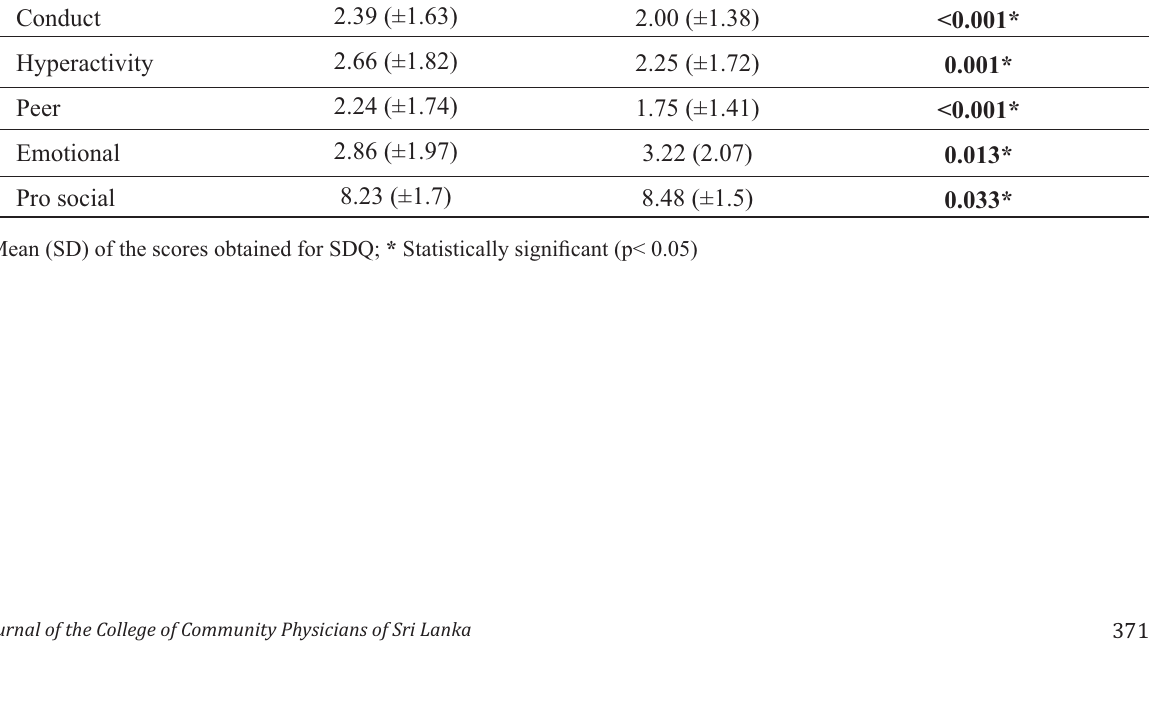
Table 1: Distribution of SDQ scores on individual mental health problems according to gender Symptom